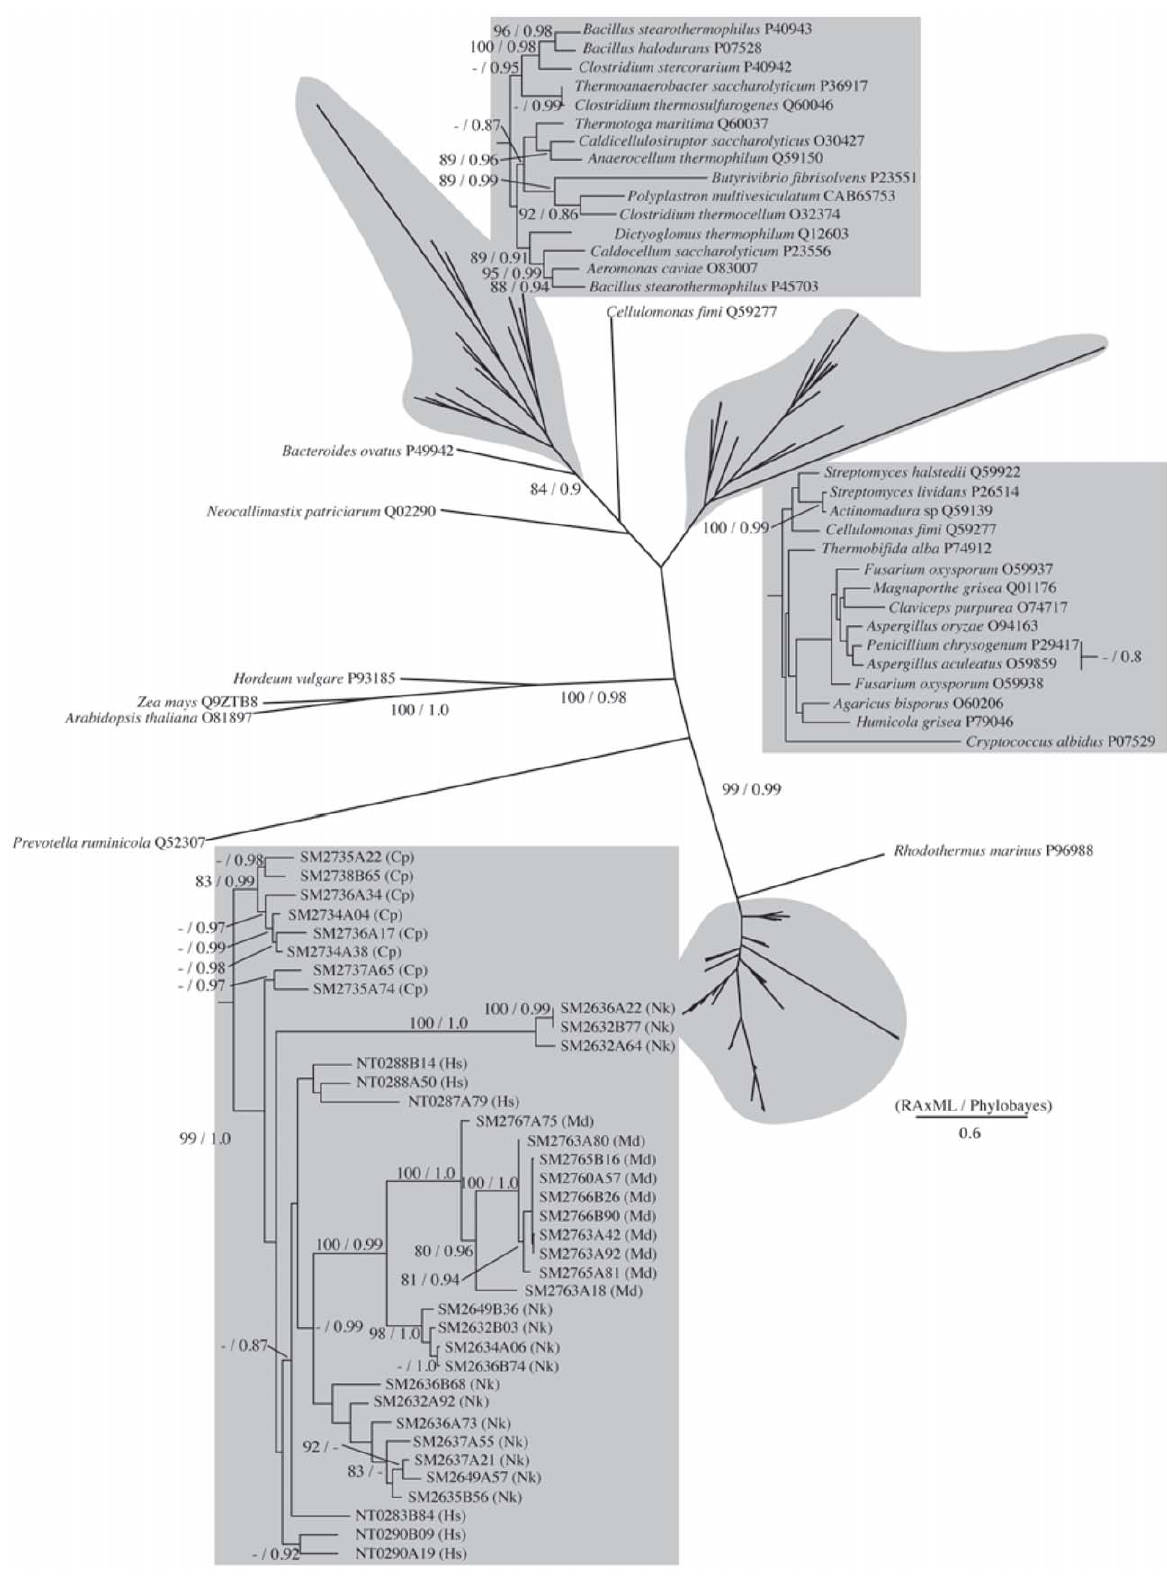
Figure 5. Phylogenetic tree of GHF10. Numbered clones (for example SM2735A22) are cellulase genes identified in this study from the symbiotic protists of termites. Letters in parentheses after each clone denote host termite species (Rs = Reticulitermes speratus , Nk = Neotermes koshunensis , Hs = Hodotermopsis sjostedti , Md = Mastotermes darwiniensis , Cp = Cryptocercus punctulatus ). Accession numbers of reference sequences are denoted after species names.